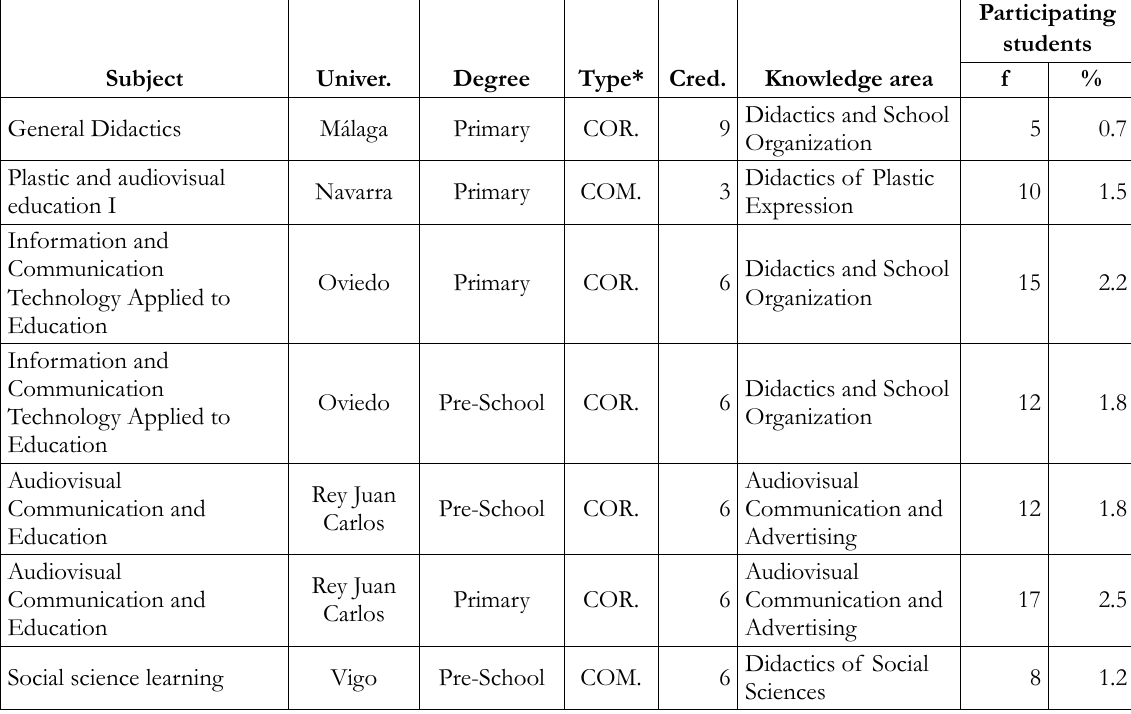
Table 4. List of the 26 subjects with the highest percentage of participating students where content on the didactic use of cinema is taught